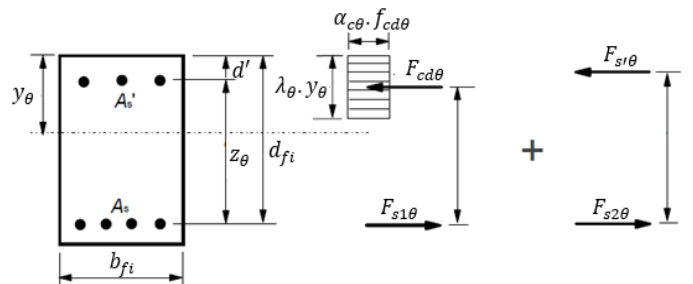
Figure 4. Equilibrium of forces in the bending section. (Source: Adapted